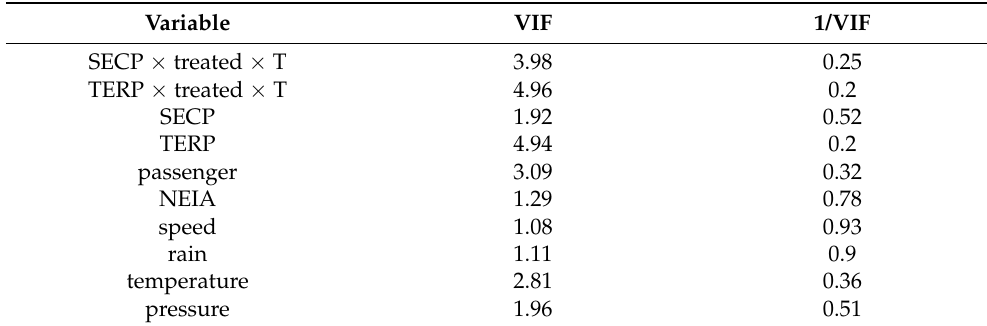
Table 3. Multicollinearity test